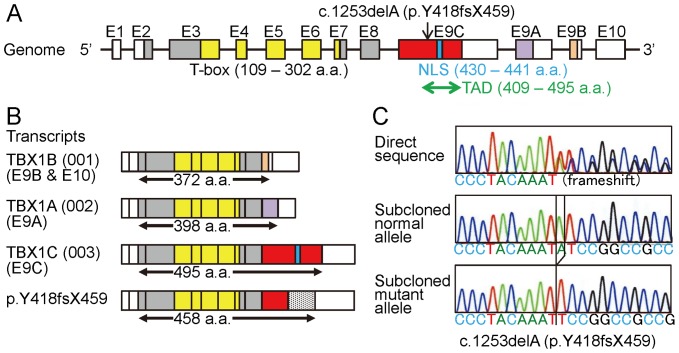

TBX1 mutation identified in this family.
A. Genomic structure of TBX1 and the position of the mutation. The color and the white boxes represent the coding regions and the untranslated regions on exons 1–10 (E1–E10), respectively; the red, the purple, and the orange segments indicate the coding regions on the final exons 9C, 9A, and 9B (splice variants), respectively. The T-box is indicated by yellow boxes, the nuclear localization signal (NLA) by a blue segment, and the transactivation domain (TAD) by a green arrow. The c.1253delA (p.Y418fsX459) identified in this family resides on exon 9C. B. Transcripts of TBX1. Three variants are formed by alternative splicing of the final exons 9C, 9A, and 9B. The c.1253delA (p.Y418fsX459) mutation is predicted to yield a truncated TBX1C protein missing the NLS and most of the TAD. The stippled box of p.Y418fsX459 denotes aberrant amino acid sequence produced by the frameshift mutation. C. Electrochromatograms showing the frameshift mutation by Sanger sequencing. The primer sequences used are: 5′-GCGGCCAAGAGCCTTCTCT-3′ and 5′-GGGTGGTAGCCGTGGCCA-3′.